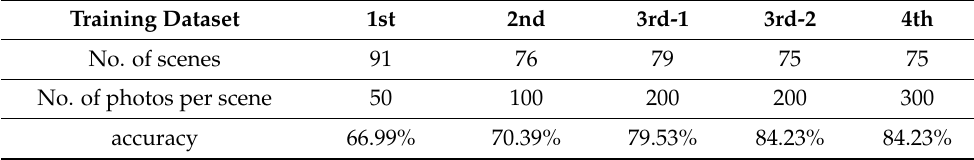
Figure 4. Process of building training dataset and re-training Inception-v3 model. Table 2. Classification accuracy according to the number of photos per scene.